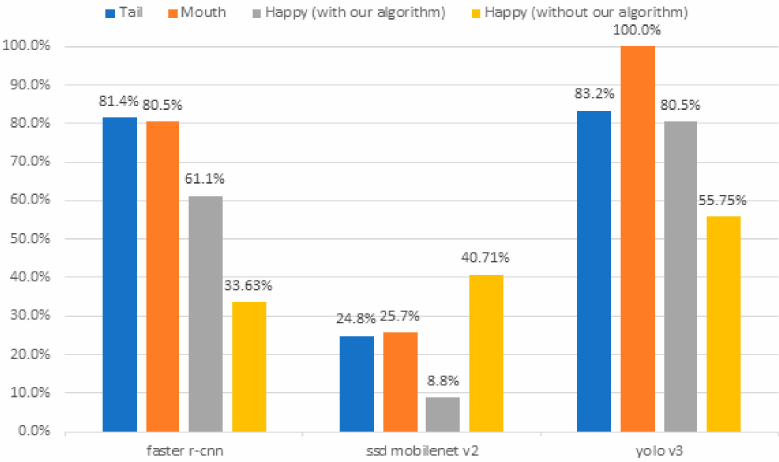
Figure 11. Identification of the accuracy for determining the happy